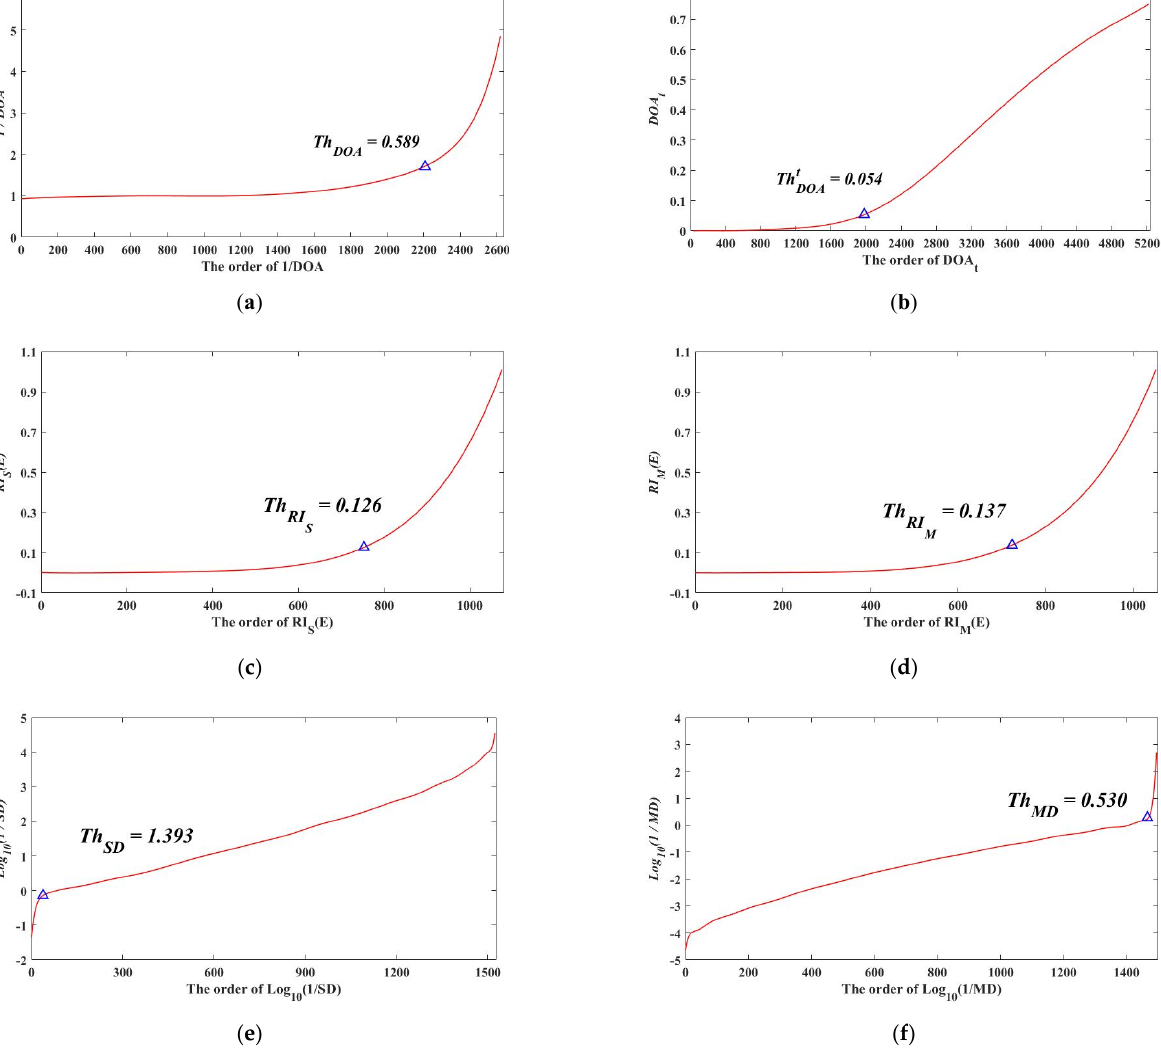
Figure 10. Parameter thresholds at different stages. The triangle symbol is located at the inflection point of the curve, and the equation represents the value of the corresponding variable at the inflection point. ( a , b ) are the linking thresholds of snapshot objects of SSTA, ( c , d ) are relative importance thresholds of snapshot objects of SSTA, and ( e , f ) are splitting/merging degree thresholds between the matched parent–child nodes (objects of SSTA at snapshots t and t + 1). In addition, ( a , b ) represent a sum of DOA and a DOA at a time snapshot, respectively. Both ( c ) and ( e ) are splitting situation. Both ( d ) and ( f ) are merging situation. Table 4. Details of the process objects of